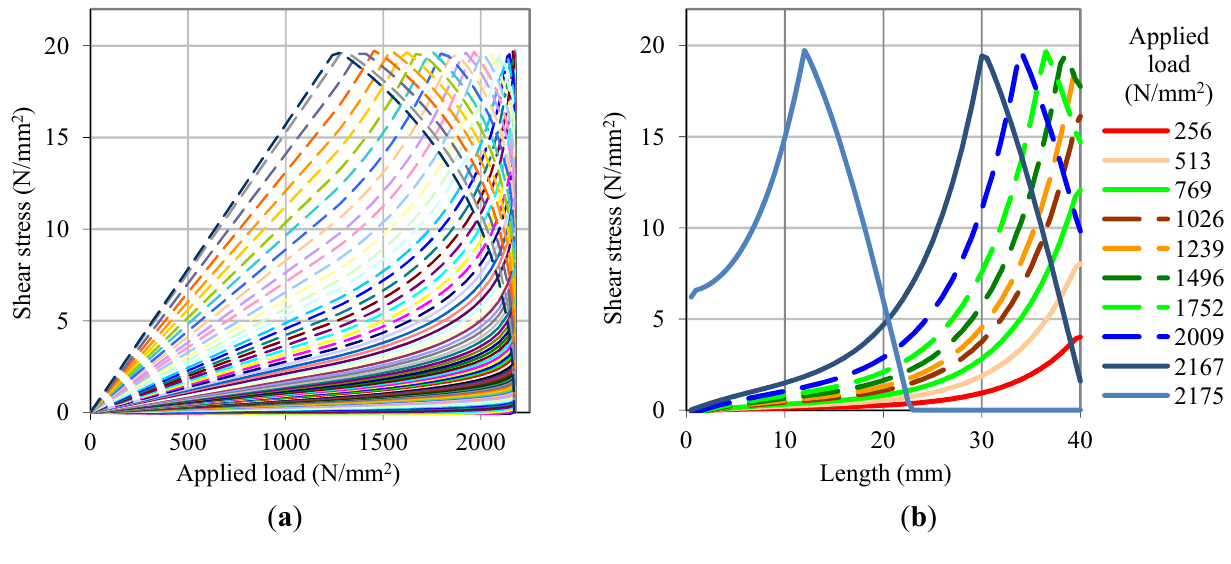
Figure 20. ( a ) Bond shear stress for every numerical element along bonding interface in function of applied load. ( b ) Bond shear stress in function of bond length. Bonding interface is loaded in direction from right to left hand